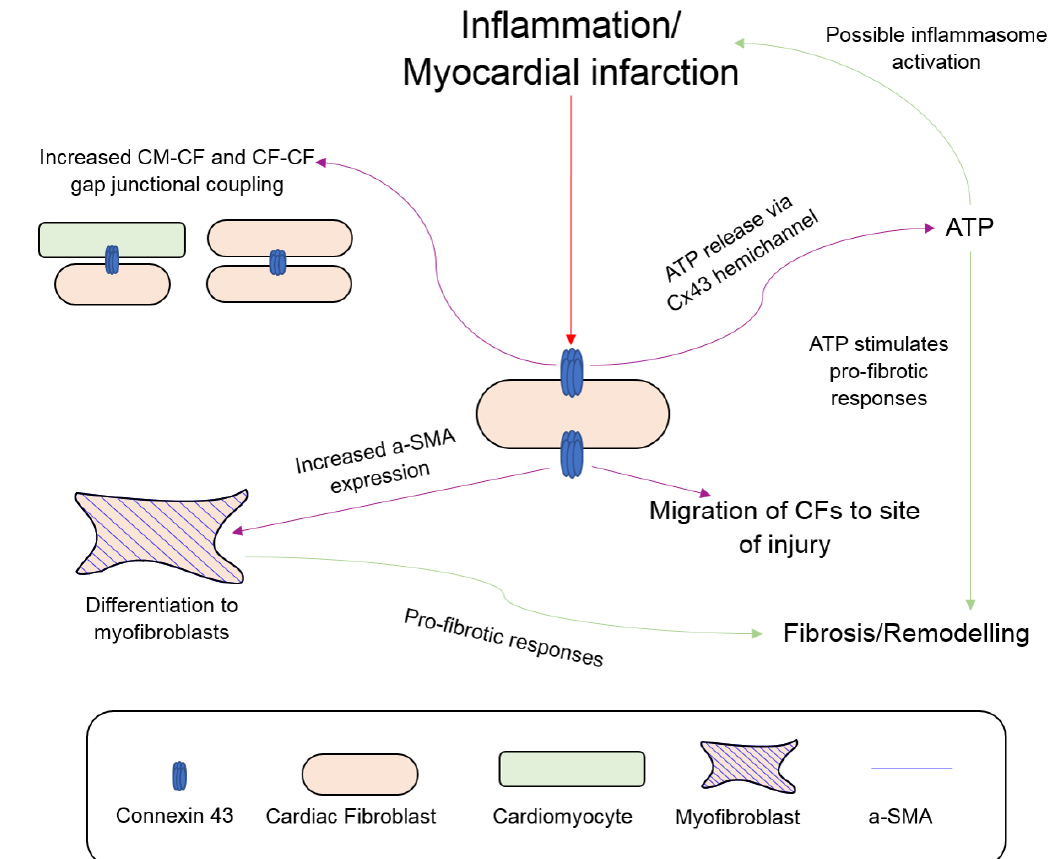
Figure 1. Connexin 43-mediated signalling in cardiac fibroblasts following inflammation/myocardial infarction. Red arrow = Inflammatory stimulus. Purple arrow = Connexin 43-mediated primary response to stimulus. Green arrow = Secondary responses following connexin 43-mediated signalling. Abbreviations: Cx = Connexin. CM = Cardiomyocyte. CF = Cardiac Fibroblast. ATP = Adenosine Triphosphate. α -SMA = α -Smooth muscle